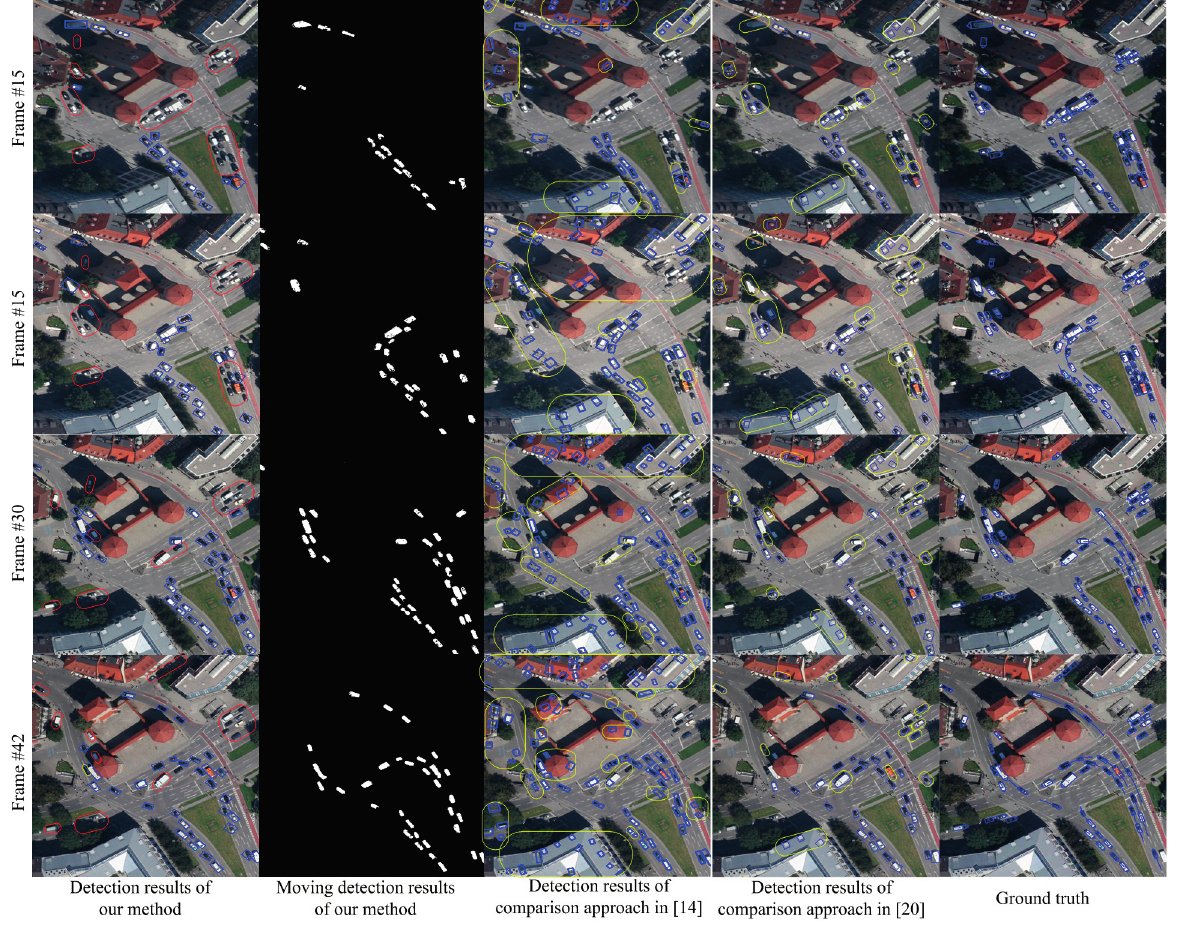
Figure 6. Detection comparisons in scenario with many buildings.